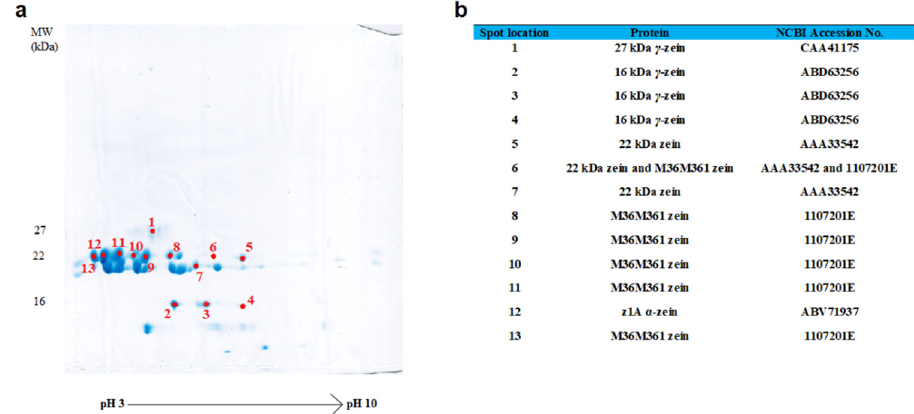
Figure 3. Zein protein separation on 2-DE gel. Detected zeins were visualized using Coomassie brilliant blue ( a ) and labelled by numbers (red), with indicated corresponding NCBI Accession numbers ( b ).